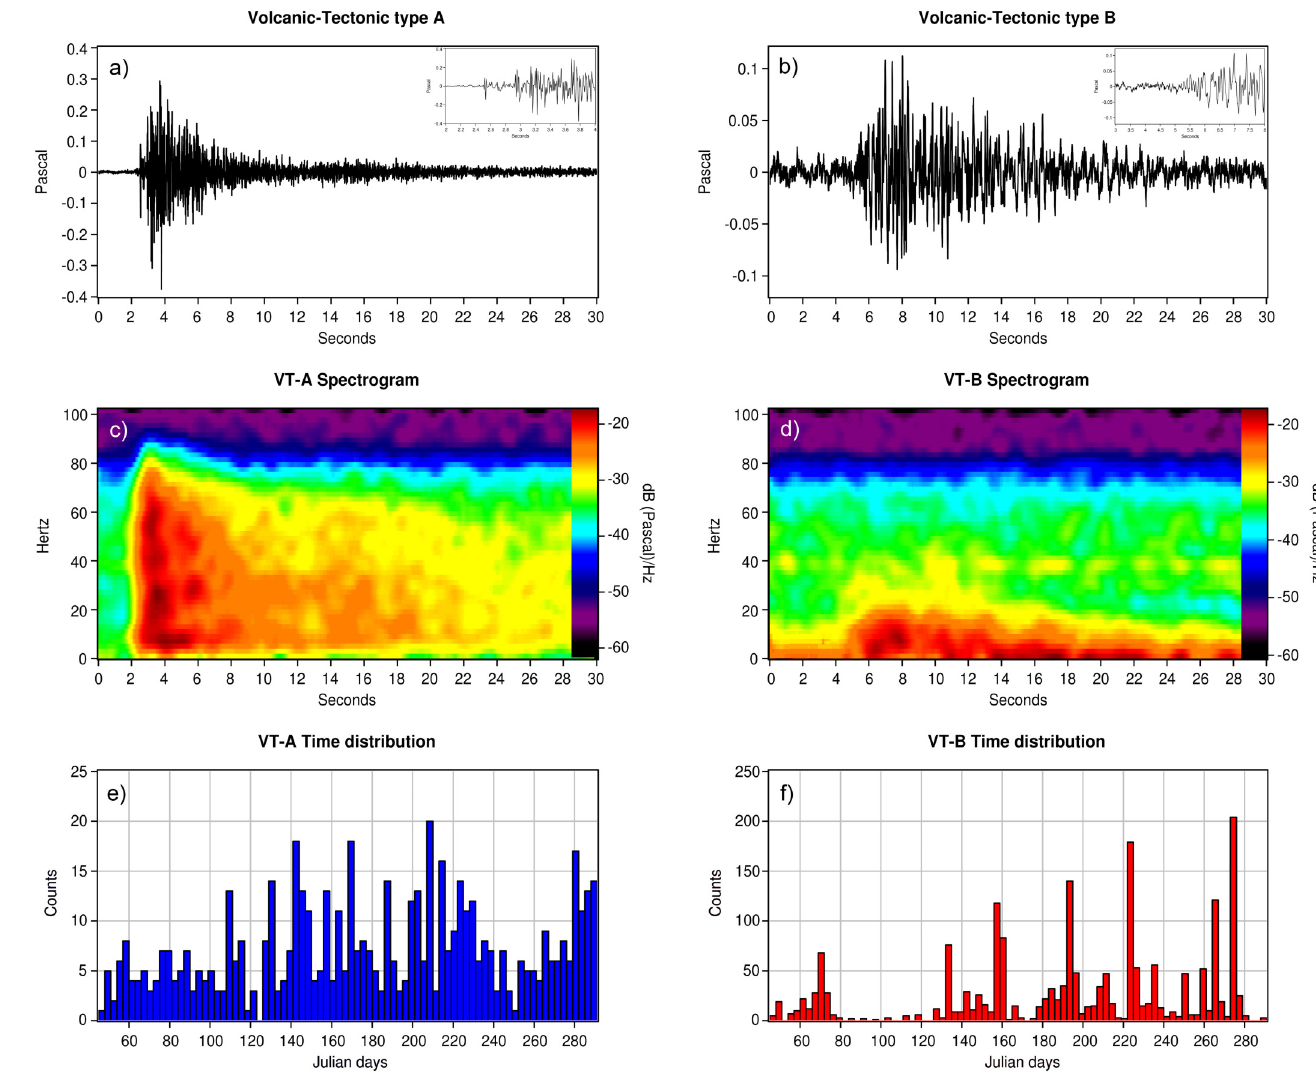
Figure 1. Waveforms (a, b), spectrograms (c, d), and time distributions (e, f) of the VT-A (a, c, e) and VT-B (b, d, f) events recorded on the Marsili volcano seamount during the 2010 monitoring campaign. Insets in (a) and (b): zoom in on the onset of the